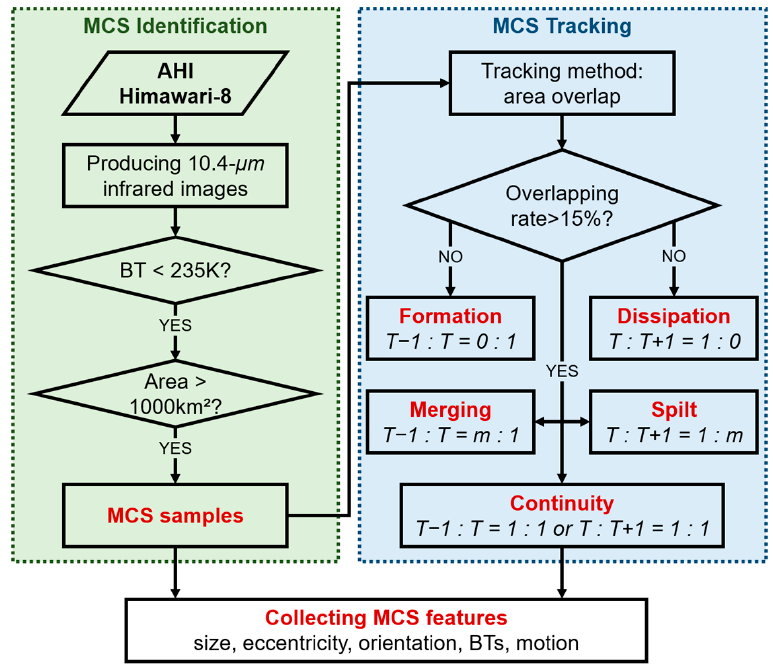
Figure 2. Flowchart of the identification, tracking and feature collection of mesoscale convective systems (MCSs) based on the Himawari-8 observations in this study.